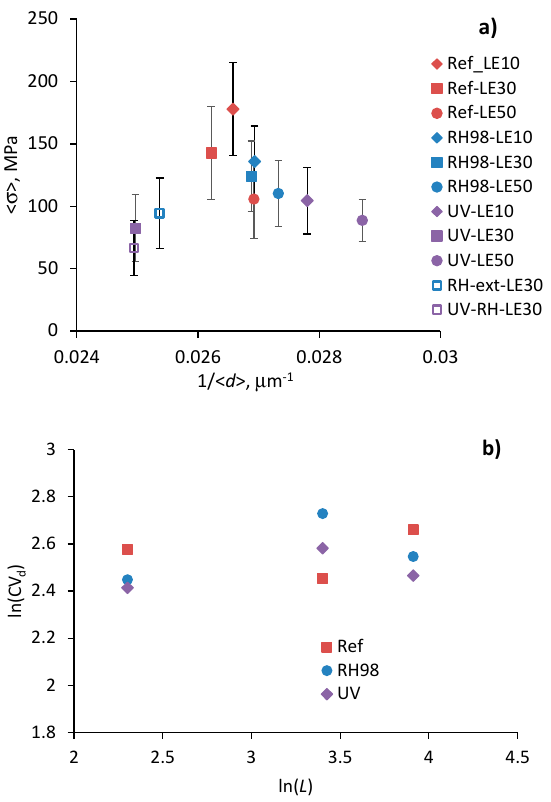
Figure 7. Average fiber strength as a function of fiber diameter ( a ) and relationship between the coefficient of variation of diameter and fiber length ( b ).